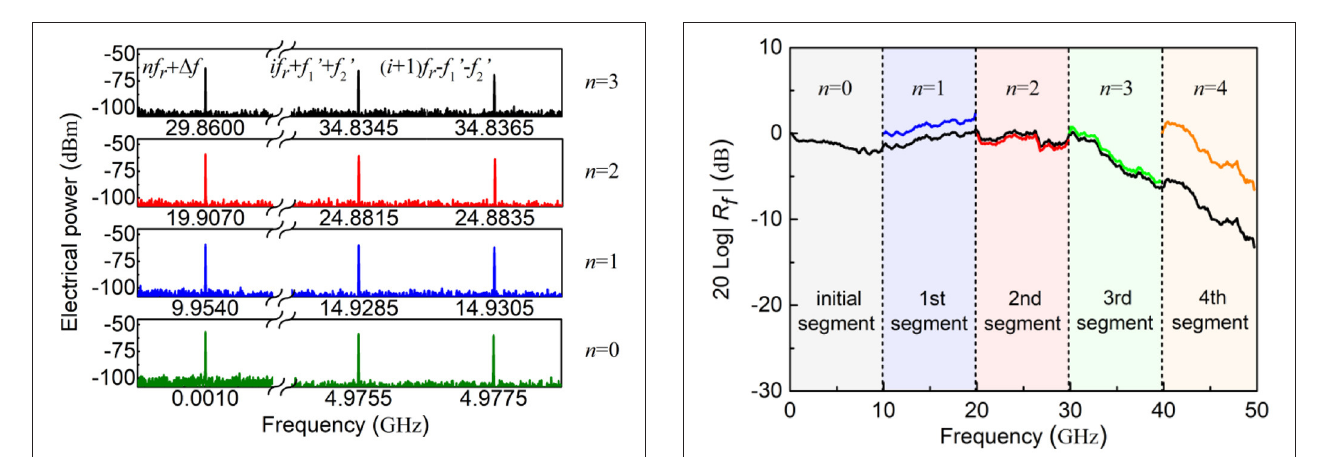
FIGURE 4 | Measured frequency response of PD before and after inter-segment stitching.